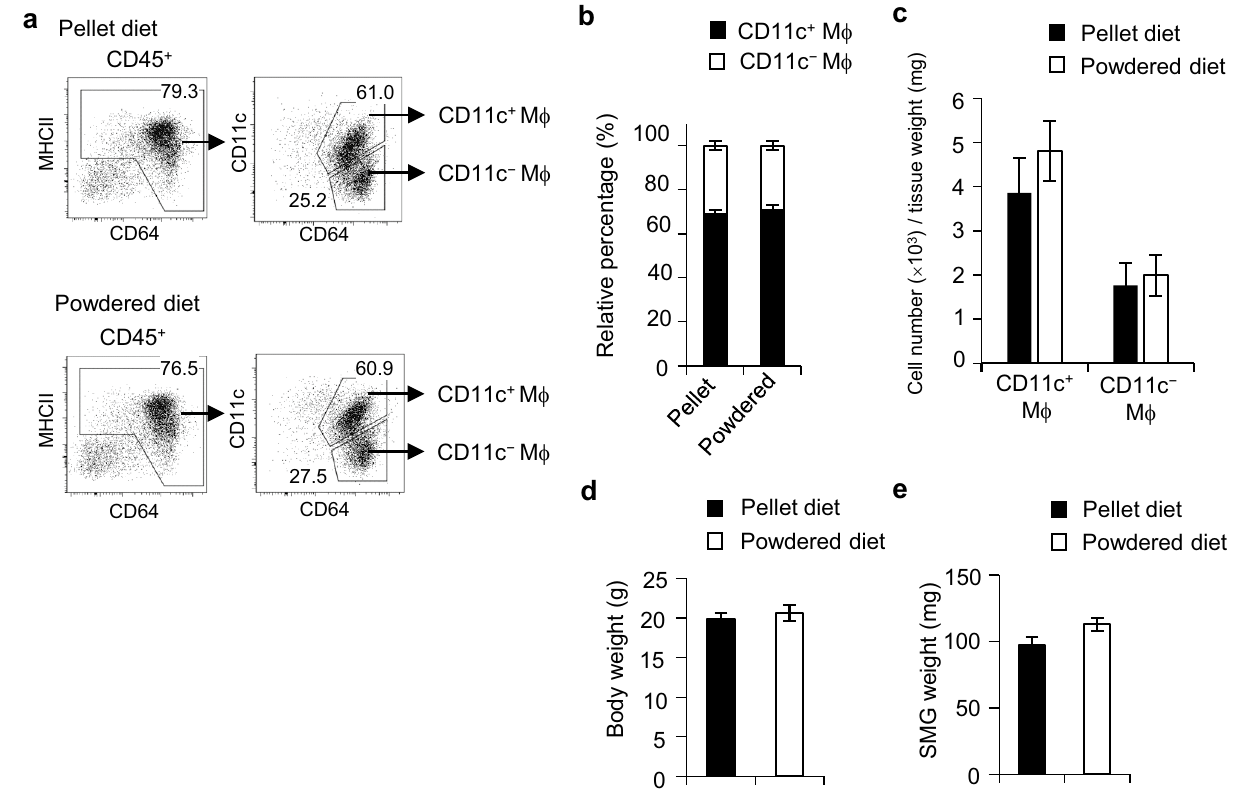
Figure 6. Effects of the diet form on macrophage subsets in steady-state SMGs. One-week-old mice and their mothers were fed standard pellets or a powdered diet. After 8 weeks, SMGs from the pups were analyzed by flow cytometry. Representative FACS plots ( a ), the proportions ( b ) and absolute numbers of CD11c + and CD11c − macrophages ( c ), body weight ( d ), and SMG weight ( e ) are shown. Bars represent the mean ± SD ( n = 3). Results are representative of three independent experiments. Mϕ